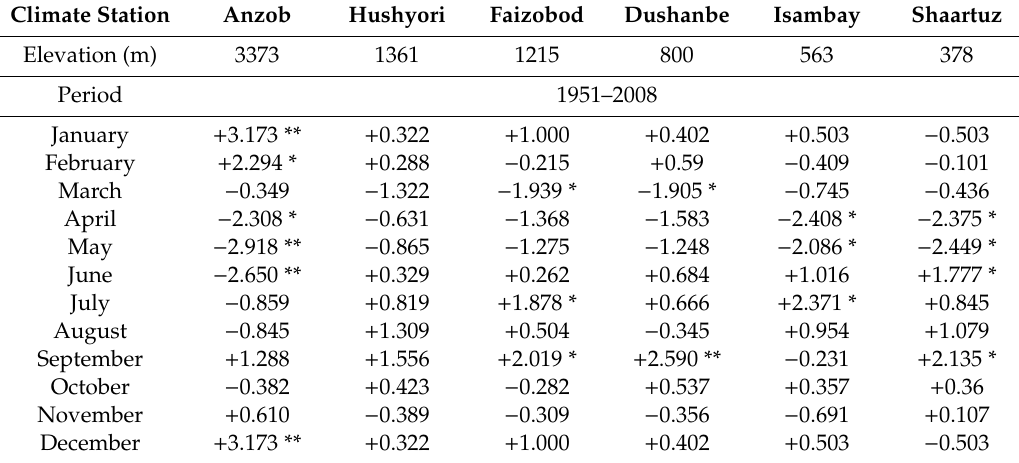
Table 5. The seasonal precipitation trend and original Mann–Kendall test in the Kofarnihon River Basin, Central Asia.